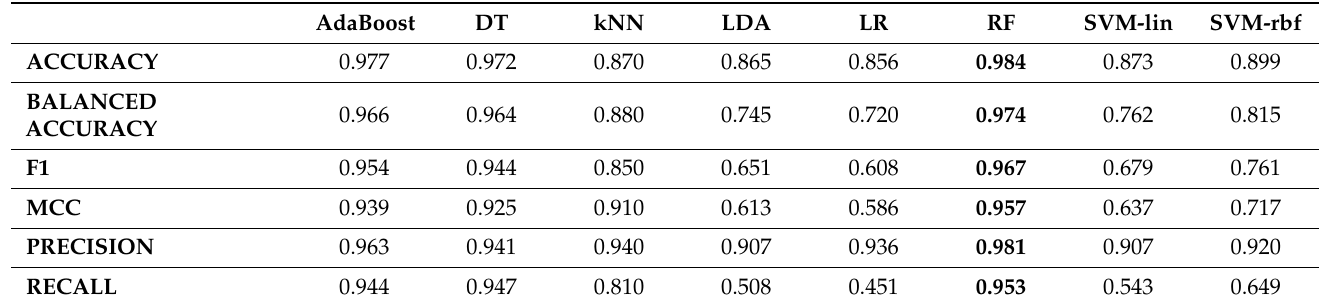
Table 2. Metrics for performance evaluation of the dependent approach (for each metric, the best performance results are identified in bold).